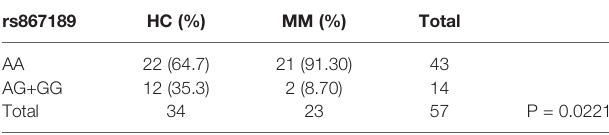
HC, healthy control; CM, cerebral malaria.